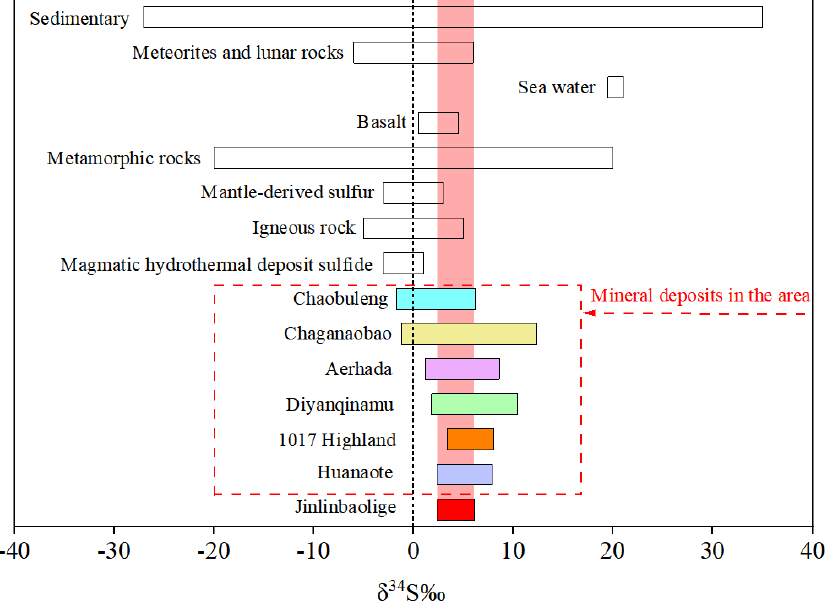
Figure 6. Distribution of sulfur isotopic composition of the Jilinbaolige deposit and